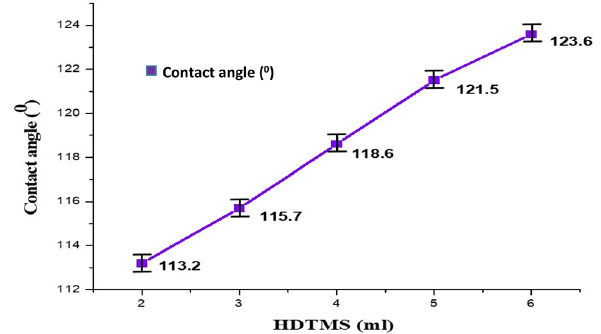
Fig. 7 A graphical demonstration of the influence of the amount of HDTMS on contact angle